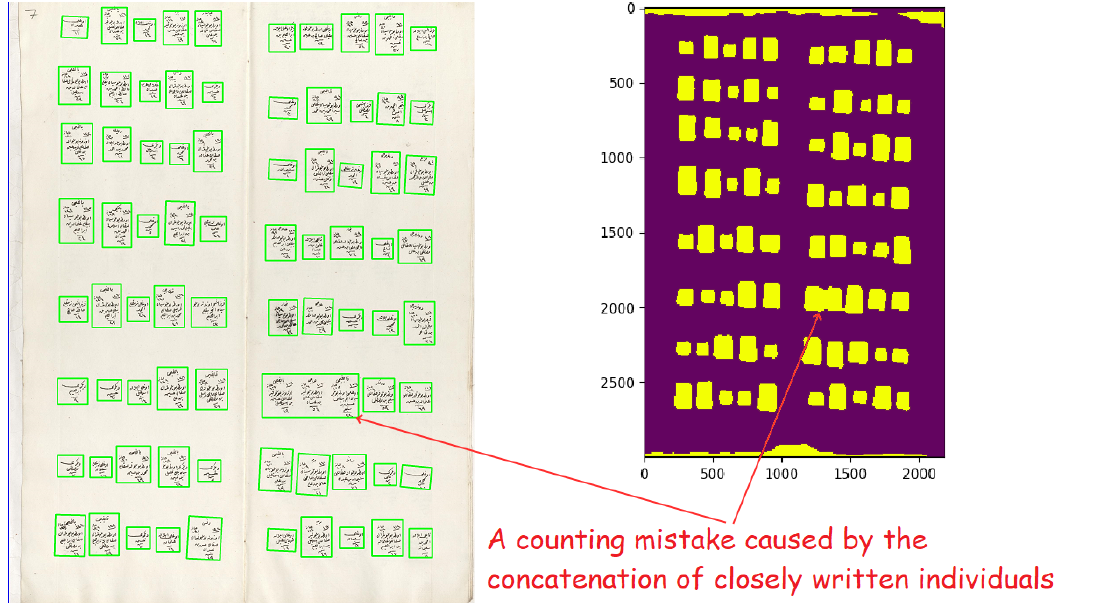
Figure 9. A sample counting mistake. All three individual registers are counted as one. This results in two missing records in our automatic counting